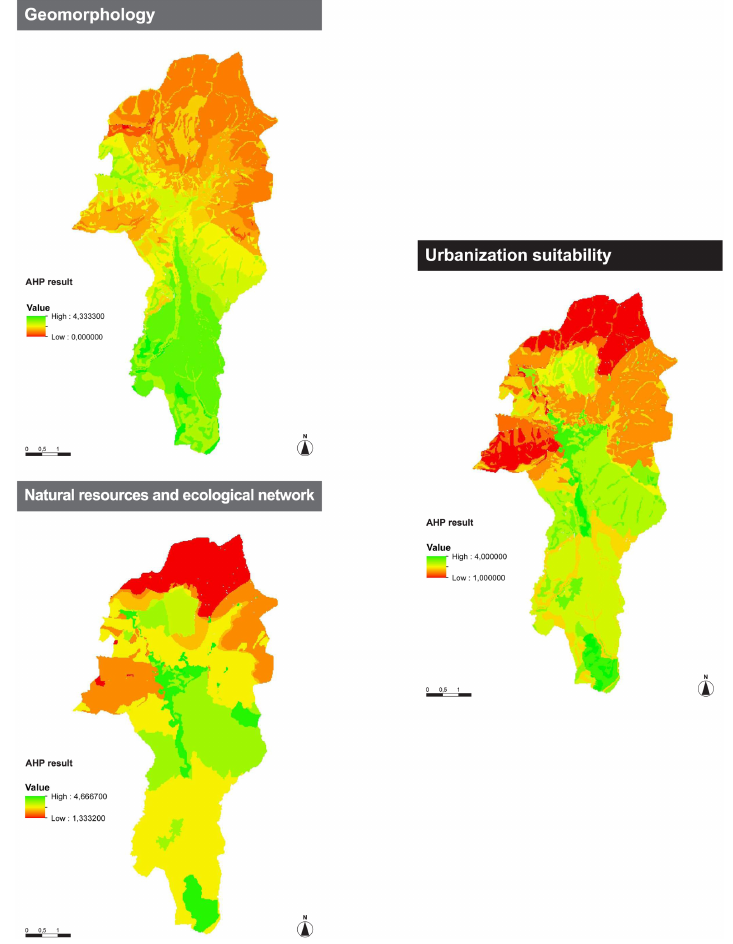
Fig. 6. Composite urbanization suitability